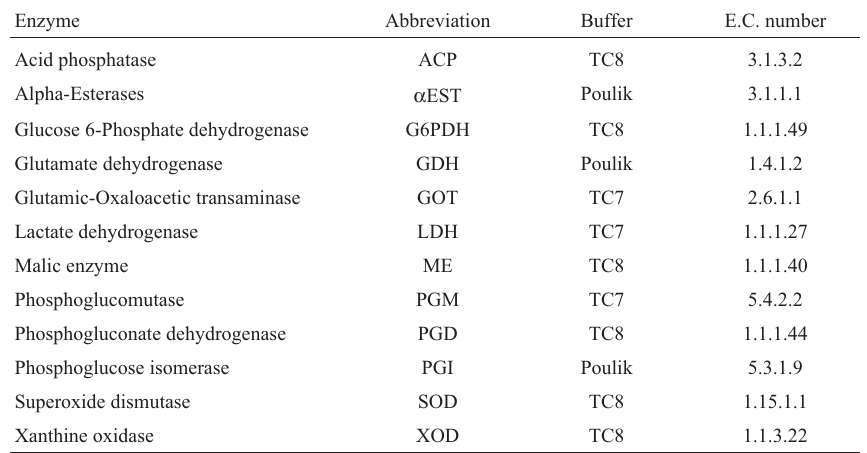
Table 2 - Enzyme systems used in allozyme electrophoresis; buffer systems: TC8 = 0.25 M Tris, 0.06 M citrate, pH 8.0 (Ward and Beardmore, 1977); TC7 = 0.135 M Tris, 0.043 M citrate, pH 7.0 (Shaw and Prasad, 1970); Poulik = 0.03 M Tris, 0.005 M citrate, pH 8.5 (gel), 0.06 M LiOH, 0.30 Borate,